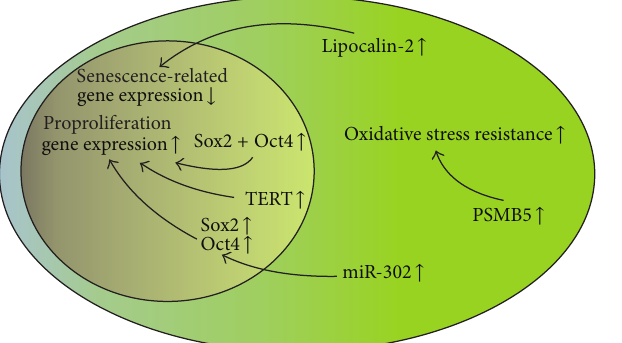
Figure 3: Proliferative and differentiation potential of MSC engi- neering. An improvement in the proliferative hallmarks of MSCs could be accomplished by the stimulation of proproliferation genes regulated by Sox2 and Oct4 transcription factors. Furthermore, senescence-related genes could be silenced (i.e., lipocalin-2 produc- tion), or oxidative stress resistance might be enhanced (i.e., PSMB5).